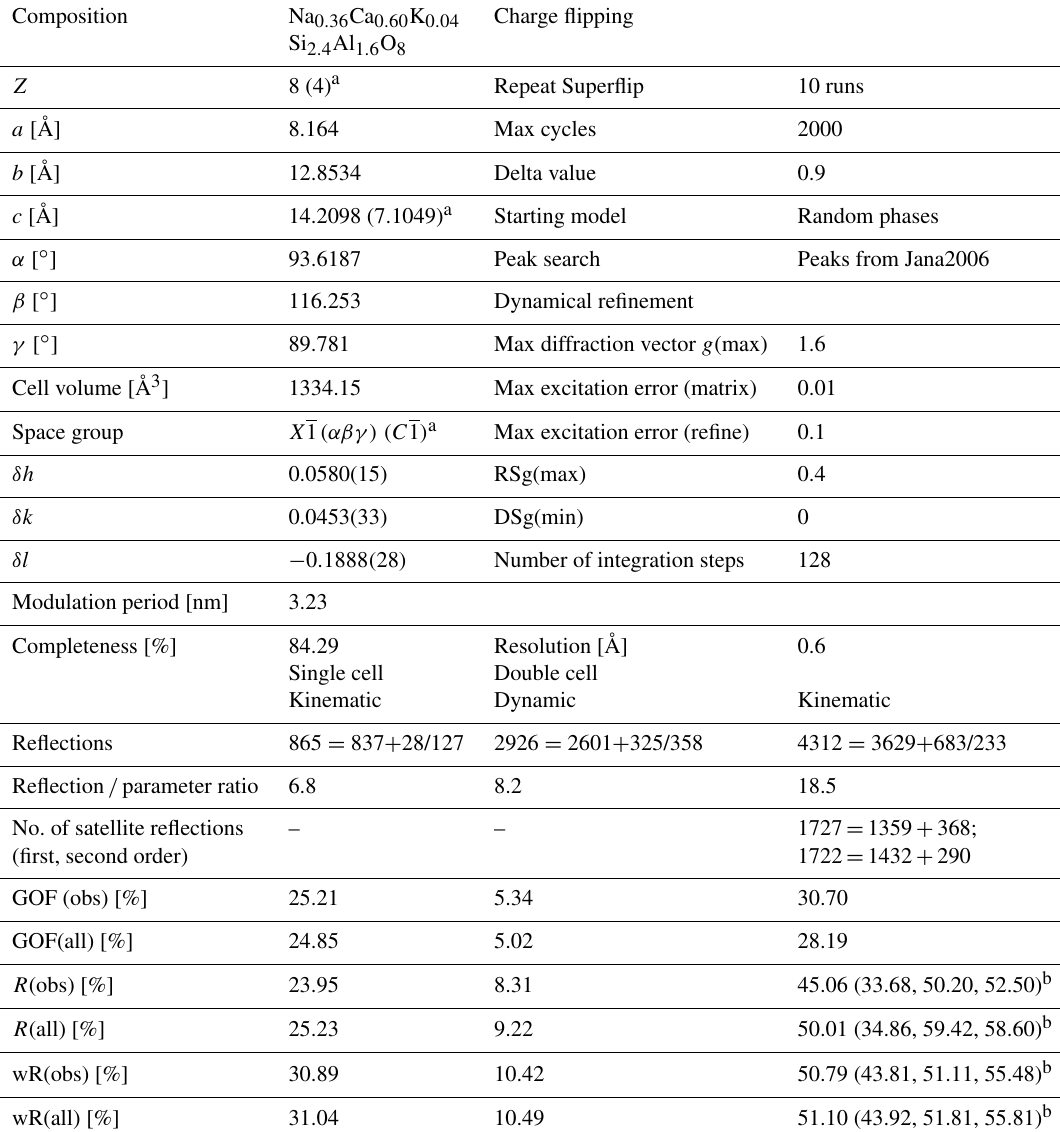
Table 1. Crystallographic details concerning the labradorite structure and its refinement. The goodness of fit is abbreviated as GOF.